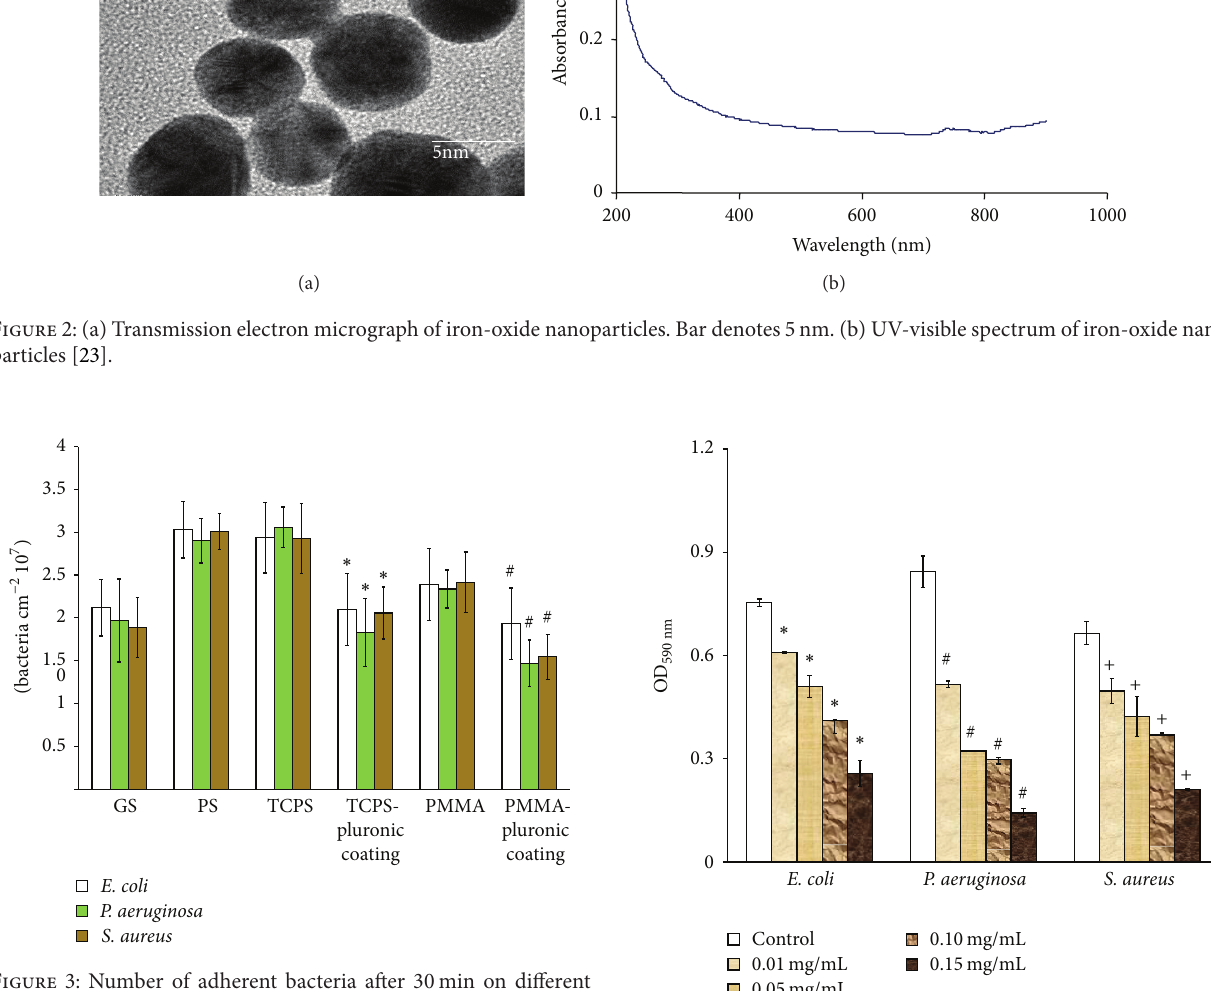
Figure 3: Number of adherent bacteria after 30 min on different biomaterial surfaces (GS: glass slide, PS: polystyrene, TCPS: tissue culture polystyrene, and PMMA: poly(methyl methacrylate)) and pluronic coated surfaces. ∗ Significant difference at 𝑃 < 0.05 compared to TCPS surfaces. # denotes significant difference at 𝑃 < 0.05 compared to PMMA surfaces.